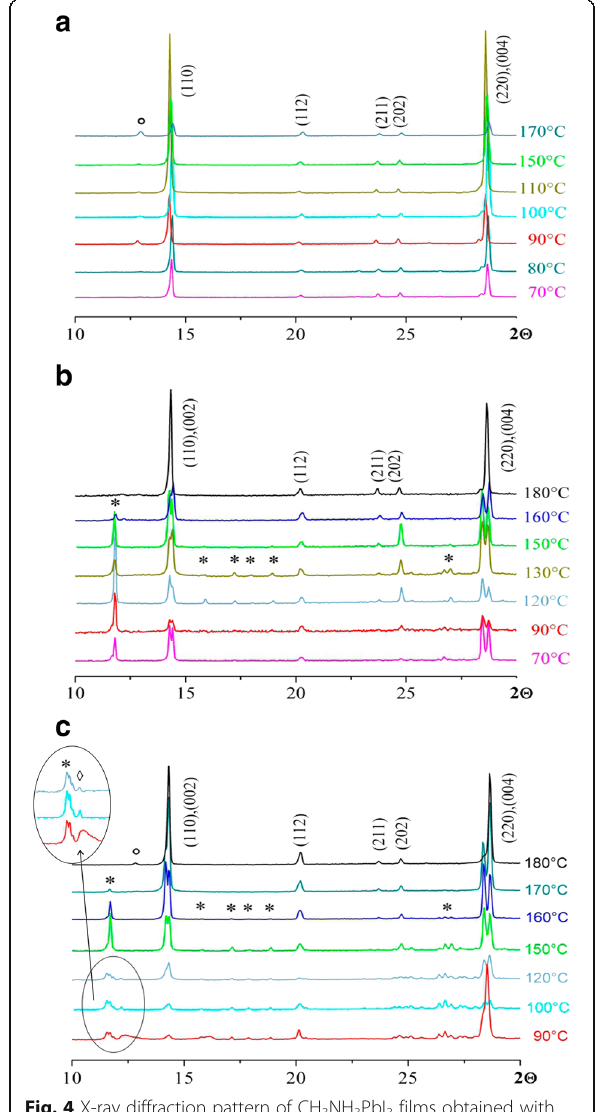
Fig. 4 X-ray diffraction pattern of CH 3 NH 3 PbI 3 films obtained with different ratios of the starting reagents PbI 2 and CH 3 NH 3 I: a 1:1. b 1:2. c 1:3.Asterisk denotes (CH 3 NH 3 ) 2 PbI 2 ; diamond denotes (CH